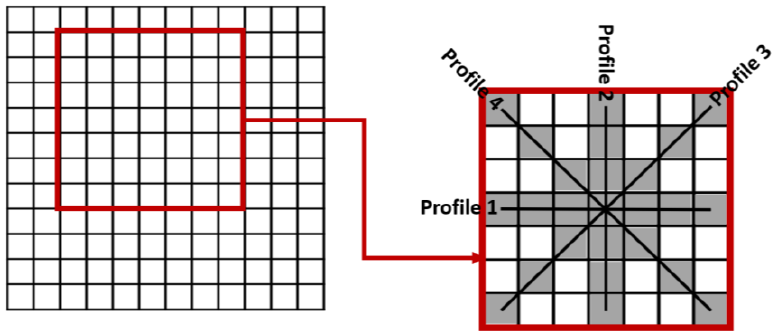
Figure 5. Definition of the four profile axes used to analyze the curvature morphology of the gullies with Multi Profile Curvature Analysis (MPCA).